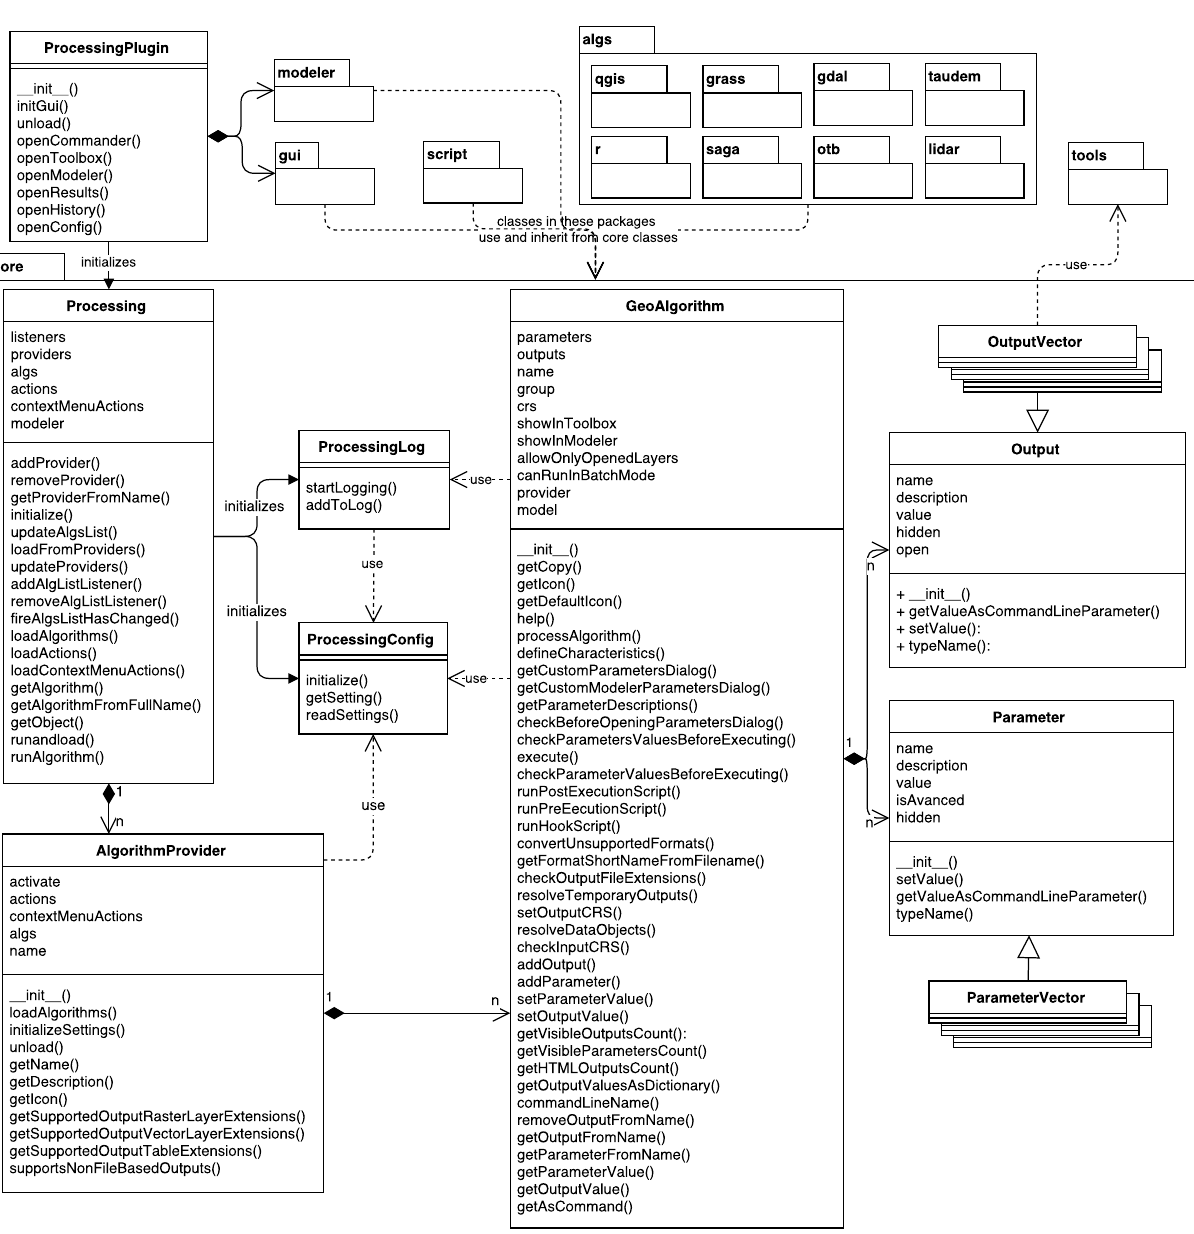
Figure 2. Class diagram of the core package and its connection to other